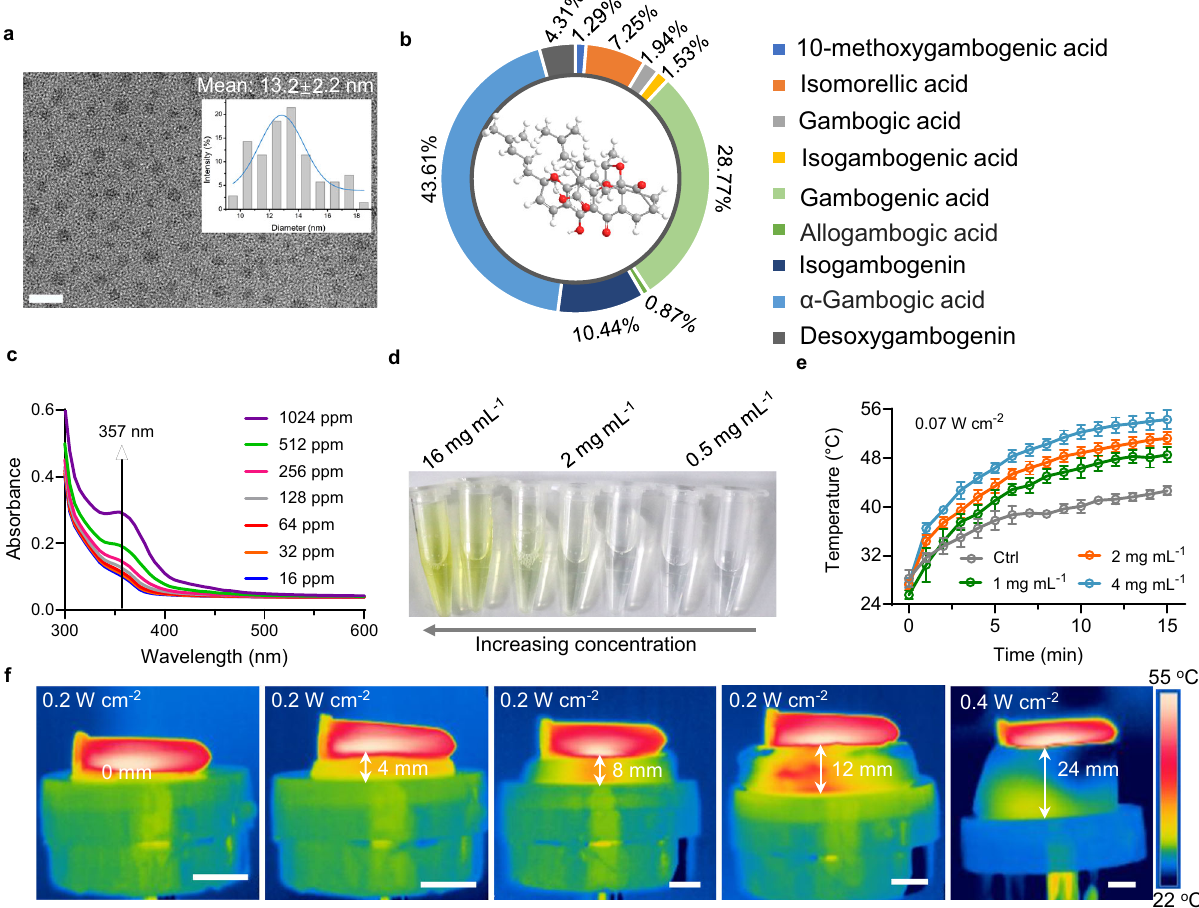
Fig. 3 Composition and properties of extracted GNs. a Typical TEM image of the GNs. Scale bar, 50 nm. Insert: the particle size distribution of GNs. b The chemical compositions of GNs and the ratio of each component. c UV absorbance spectra of aqueous suspensions of dispersed GNs at various concentrations, and the maximum absorbance of dispersed GNs at 357 nm. d Pictures of aqueous solutions with different GNs concentrations. e MV thermal curves of different concentrations of GNs. Data are presented as mean ± standard deviations from a representative experiment ( n = 3 independent samples). f Infrared thermal images of GNs through different thicknesses (0, 4, 8, 12 mm and 24 mm) of pork tissue under MV excitation. Scale bar, 1 cm. Source data are provided as a Source Data fi